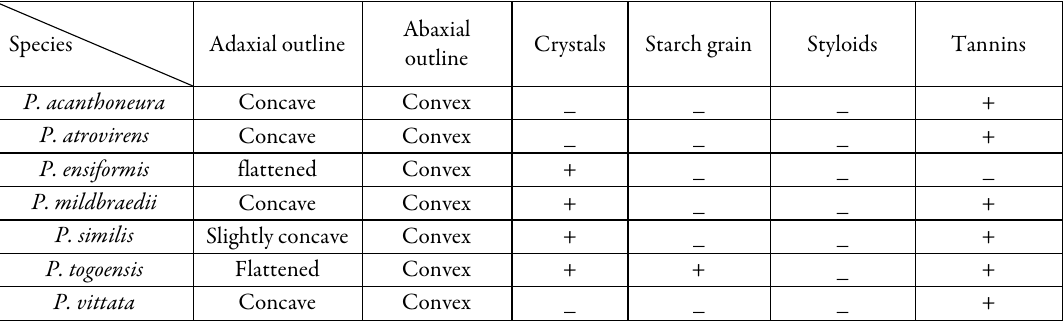
Table 3. Summary of the features in distal regions of stipes of the Pteris species